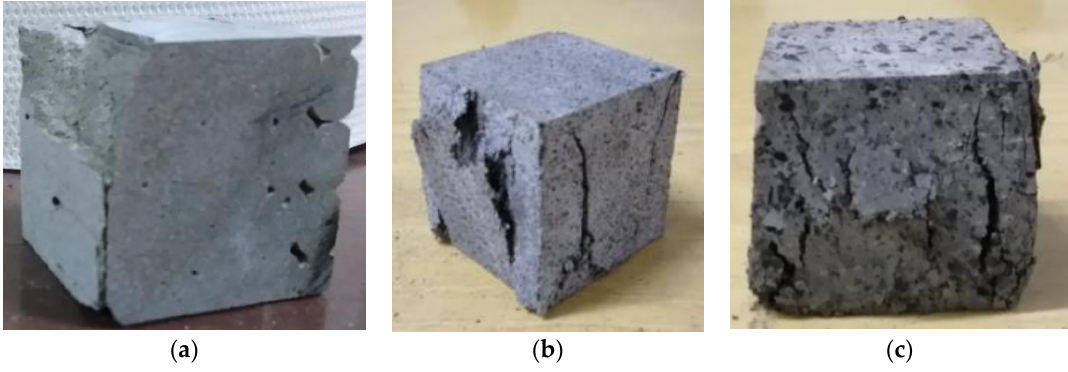
Figure 13. Failure pattern after compressive test: Control ( a ), P100 ( b ), and P50-G50 ( c ).